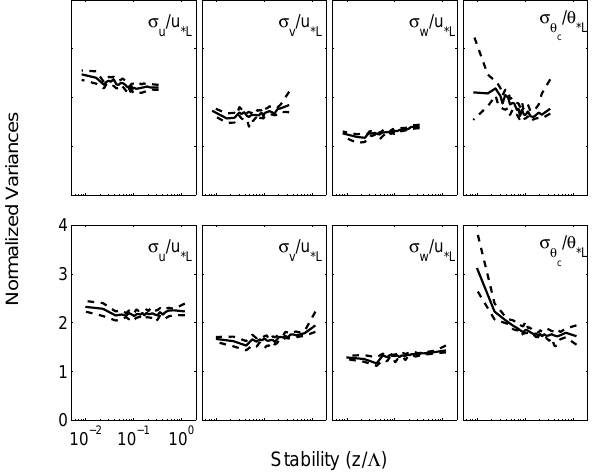
Fig. 3. The panels from left to right represent normalized vari- ances σ u /u ∗ L , σ v /u ∗ L , σ w /u ∗ L , and σ θ upper and lower panels correspond to the 3.1m and the 7m sonic anemometers, respectively. All the panels have identical abscissa and ordinate limits.